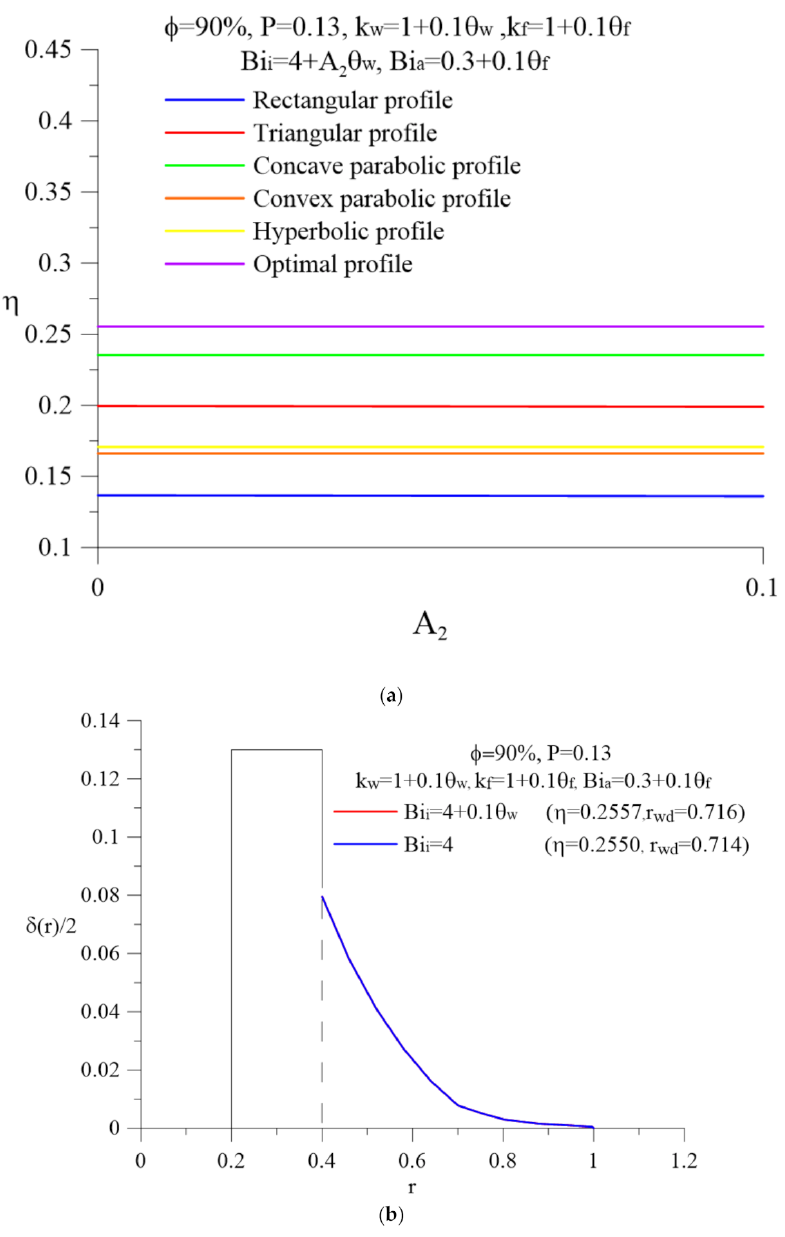
Figure 7. ( a ) The comparisons of η for different types of fins with various Bi i . ( b ) The estimated optimum shapes of fins with various Bi i